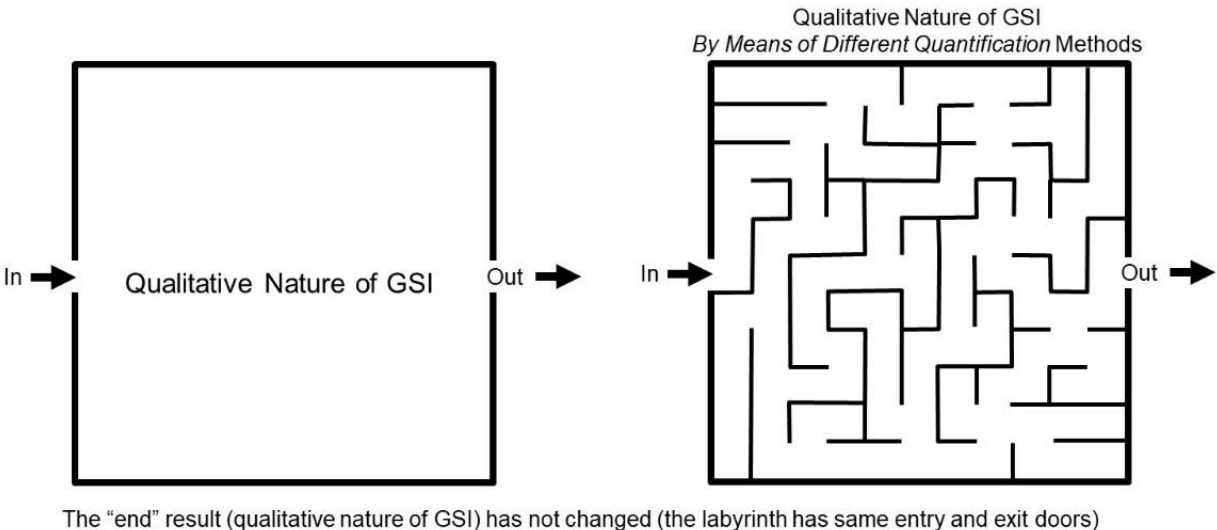
Figure 9. The allegory of the unnecessary labyrinth to explain the chaos created by adding a variety of quantification methods for something like GSI that is and will always remain a qualitative assessment. Given the arguments articulated throughout the paper to discuss the limitations and impracticality of quantifying the original GSI table, the following recommendations